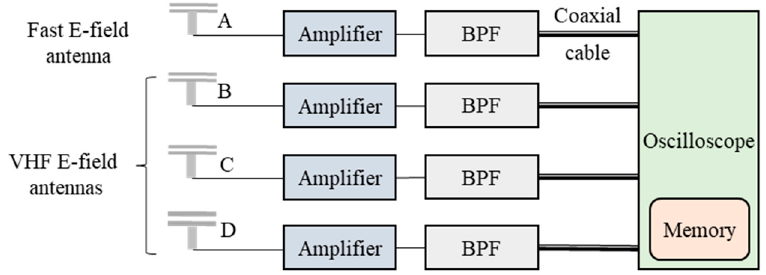
Figure 3. VHF broadband digital interferometer data acquisition system.